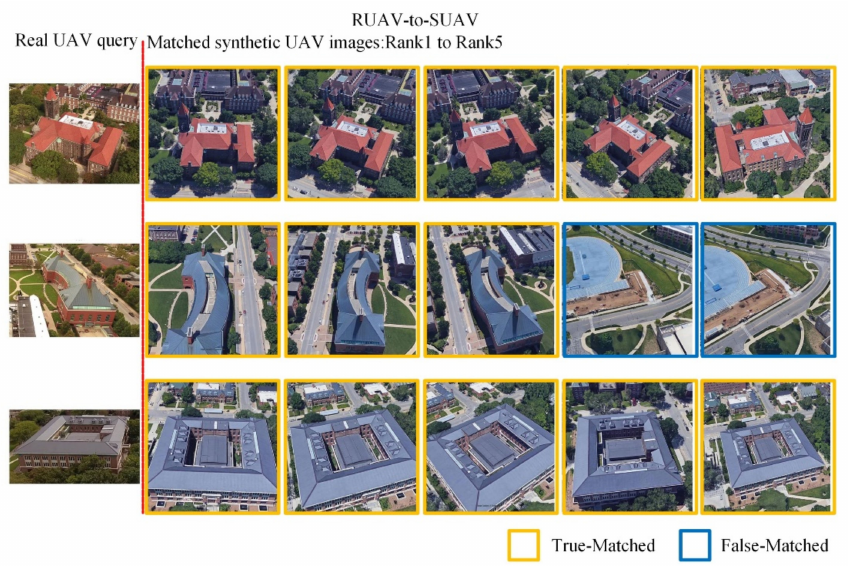
Figure 10. The matching result for RUAV-to-SUAV (the real UAV-view image as a query to match the synthetic UAV-view image).